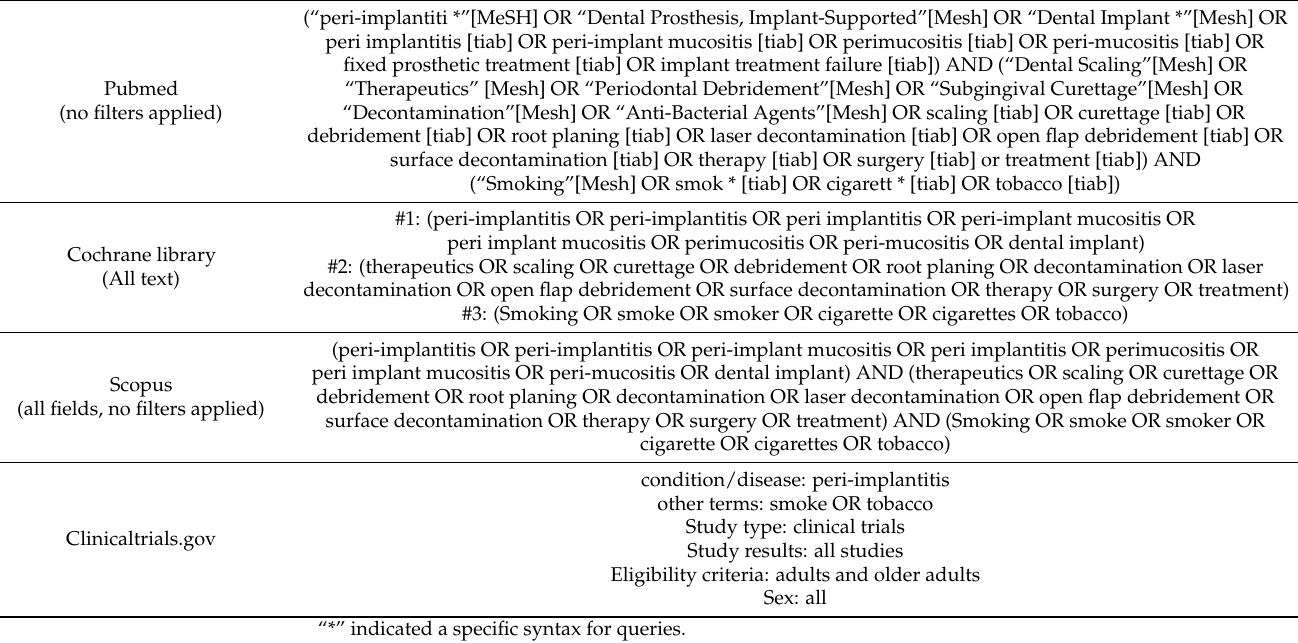
Table 1. Databases and search